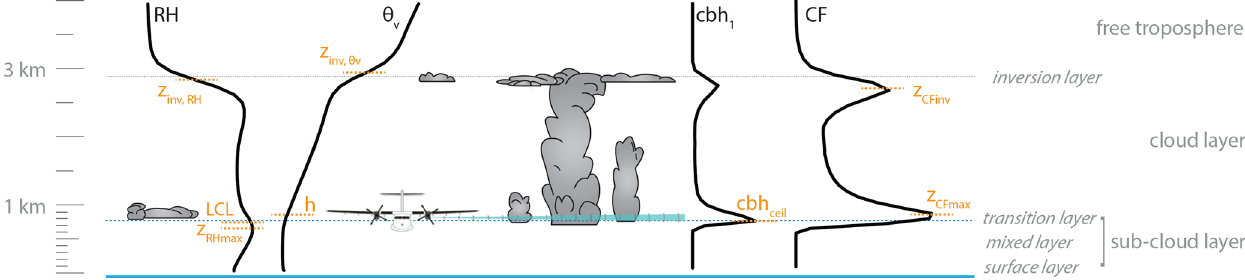
Figure 3. Schematic representation of the trade-wind layer with the different levels considered as part of the ground support to determine the cloud base level of the ATR, plus sometimes the cloud top level. The subcloud-layer top, referred to as h or z SC , is defined as the level of neutral buoyancy of a parcel originating from the surface layer with a 0.2K excess in θ v (Sect. 2.5); z CFmax is the level of maximum near-base cloud fraction (as would be seen for instance in ground-based radar observations), cbh ceil is the peak of the distribution of the first-detected cloud base height (cbh) of the ceilometer, z RHmax is the level of maximum relative humidity (RH) at the mixed-layer top, LCL are the inversion heights based on the maximum gradients in RH and θ v , and z CFinv is is the lifting condensation level, z inv , RH and z inv ,θ v the second level of maximum cloud fraction around the